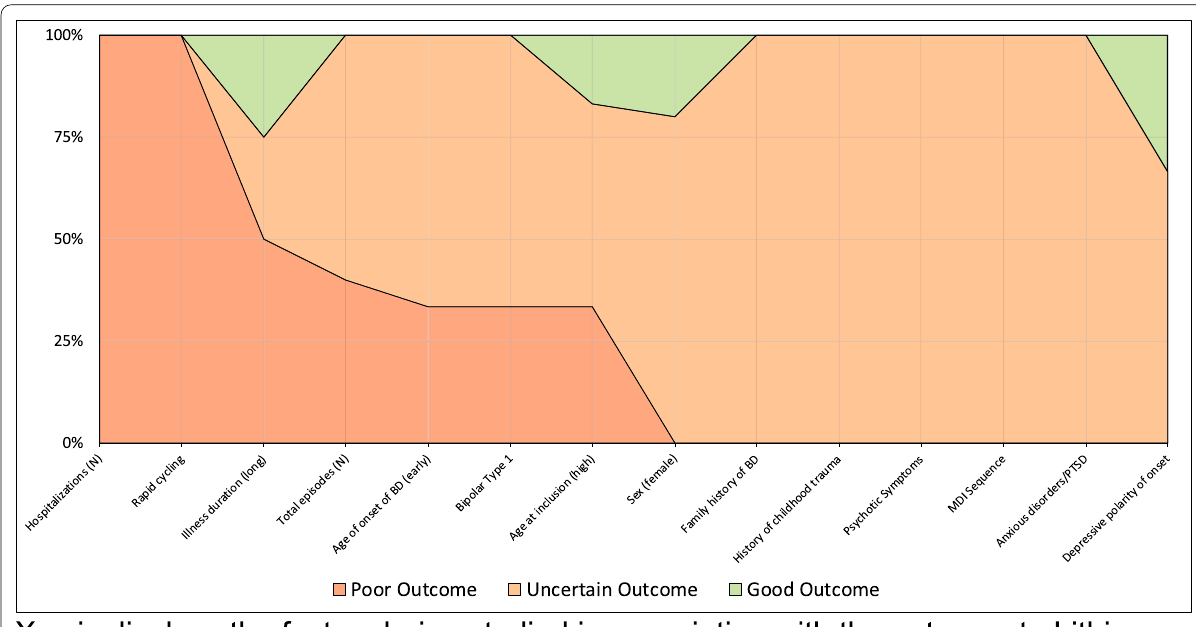
Fig. 4 Diagram graph of all potential predictors being studied in at least 2 studies, only in prospective